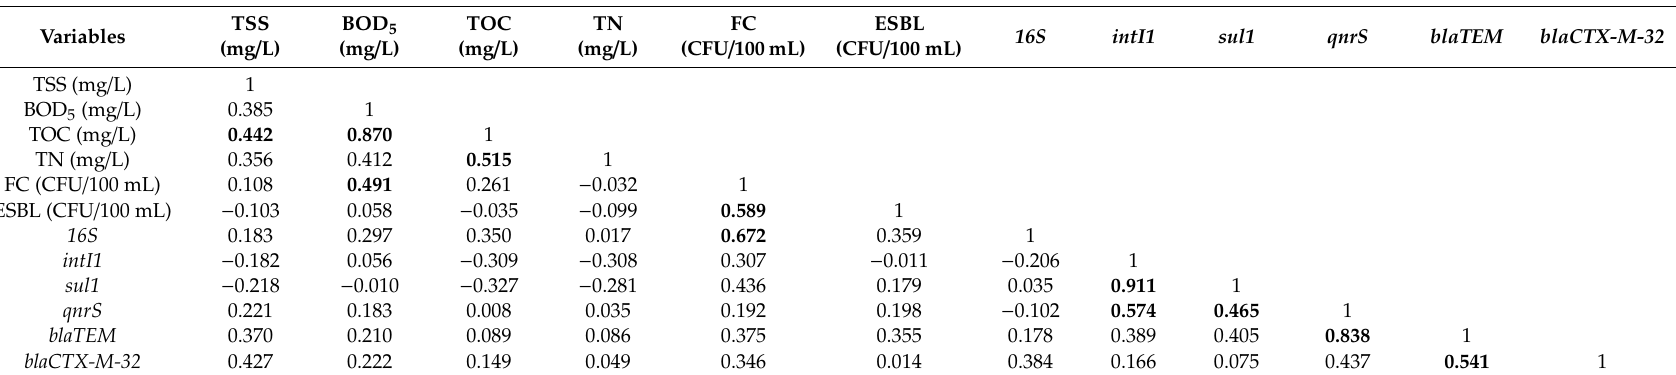
Table 2. Correlation matrix relating antimicrobial resistance gene abundance, total fecal coliforms (CFU / mL), ESBL (CFU / mL), and physiochemical parameters. Values in bold indicate statistically significant correlations (Pearson) with a p -value <